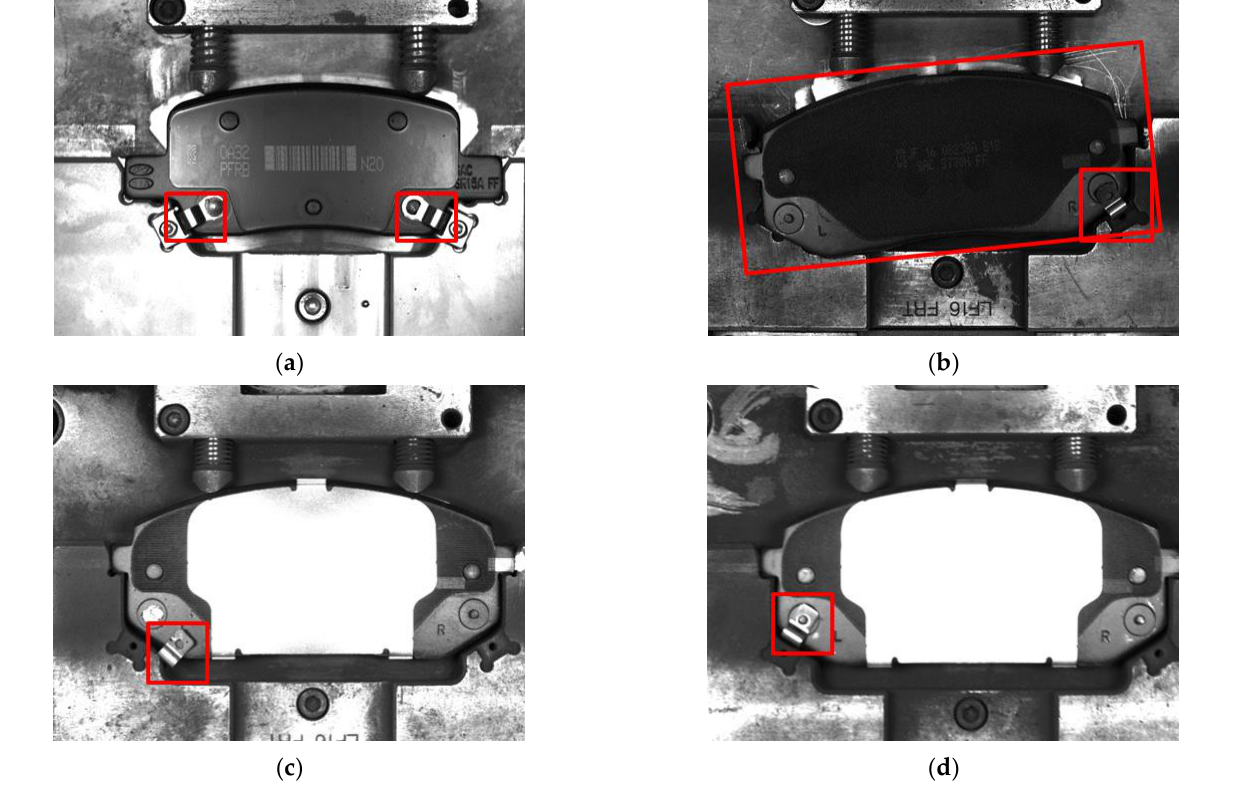
Figure 5. Defective case: ( a ) ill-positioned sensor, ( b ) ill-positioned sensor and wrong placement of the product, ( c ) ill-positioned sensor and unsuitable rivet, and ( d ) riveting not performed.